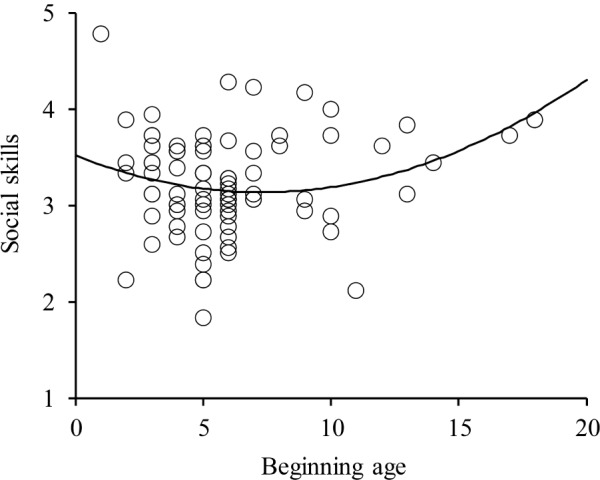
Relationship between beginning age of musical experience and social skills. Curve shows the results of a quadratic regression analysis.